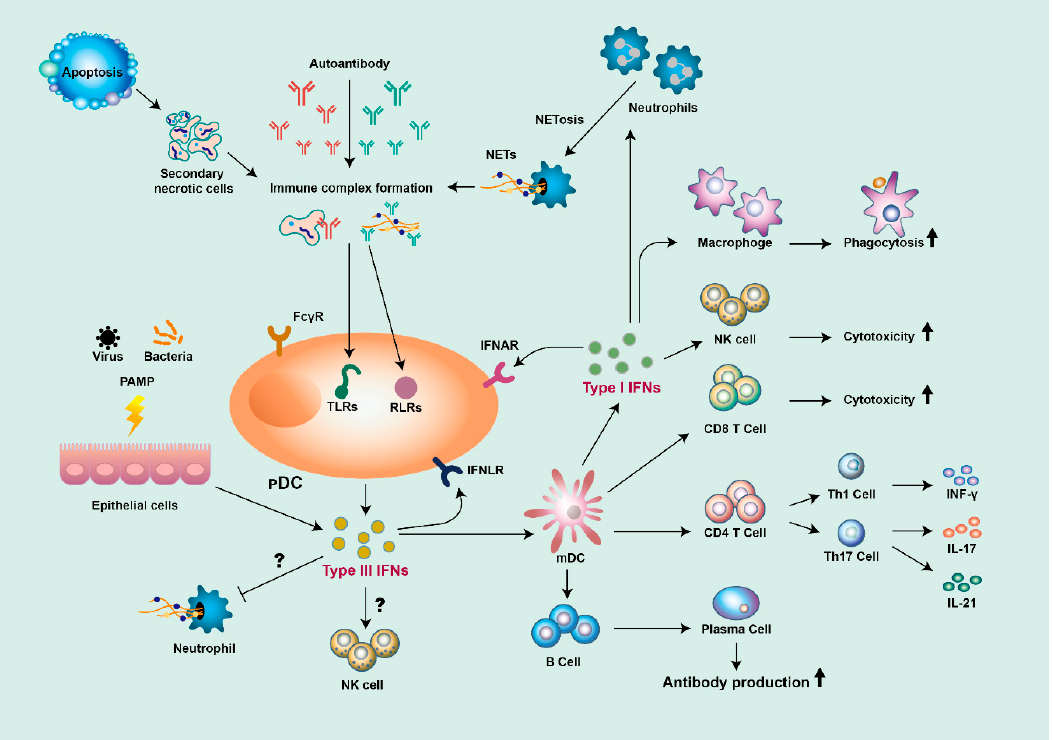
Figure 3. The roles of type I and type III IFNs in the pathogenesis of SLE (systemic lupus erythematosus). Self-nucleic acid from apoptotic cells, or from neutrophil extracellular traps (NETs) released from neutrophils, are detected by autoantibodies to form immune complexes, stimulating plasmacytoid dendritic cells (pDCs) to produce type I and type III IFNs. Epithelial cells also produce type III IFNs in response to pathogen-associated molecular patterns (PAMPs). Both type I and type III IFNs stimulate myeloid DCs (mDCs) to activate T- and B-cells, which leads to the production of diverse proinflammatory cytokines and autoantibodies. Type I IFNs can also promote cytotoxicity function in macrophages and natural killer (NK) cells. Both type I and type III IFNs can contribute to a positive feedback loop of